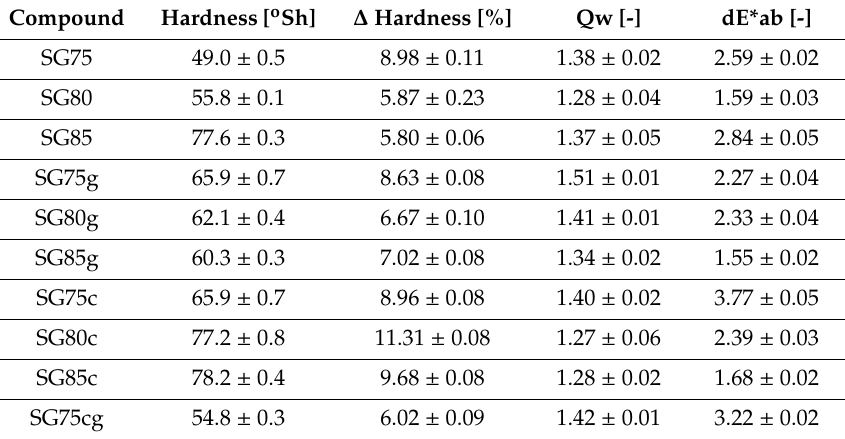
Table 2. Hardness and equilibrium swelling in water (Qw) of selected starch films, and color change coe ffi cient (dE*ab) and hardness of starch films after biodegradation ( ∆ Hardness). Compound